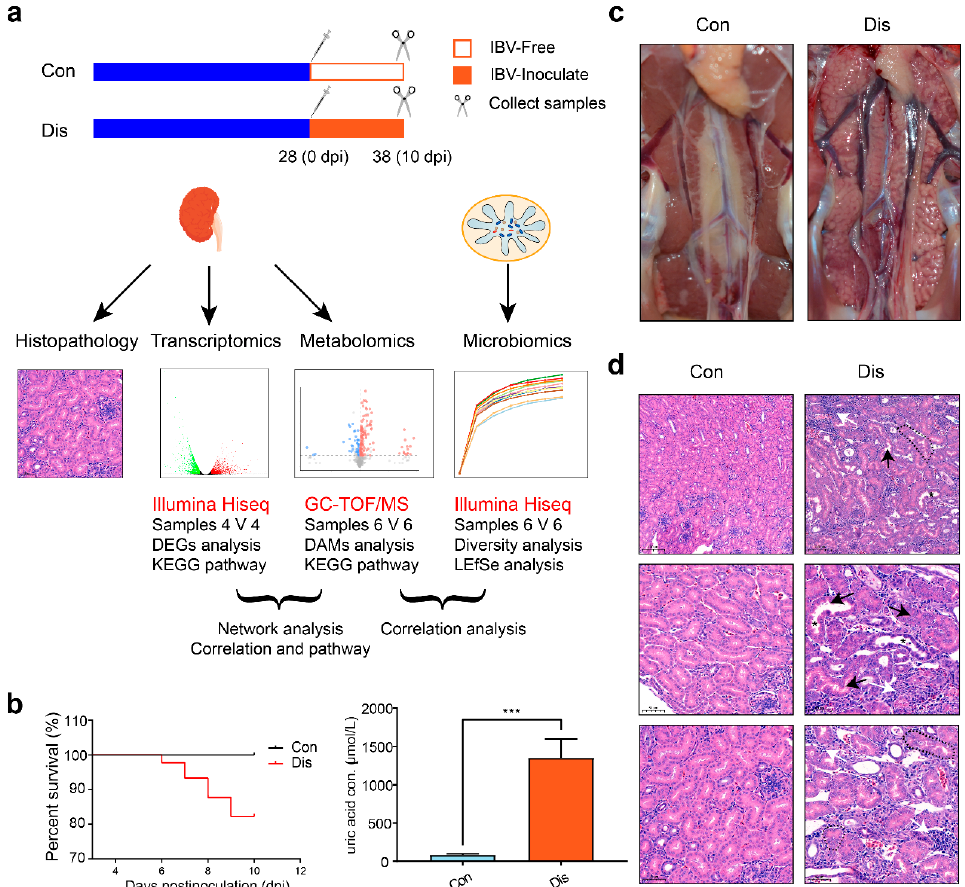
Figure 1. Changes in the kidney of chickens infected with nephropathogenic infectious bronchitis virus (NIBV). ( a ) Experimental design, including the analysis of transcriptomics, metabolomics, and microbiomics. ( b ) Analysis by Kaplan–Meier curve of 10 dpi survival rate in NIBV-infected chickens and uric acid concentrations in the serum. ( c ) Gross lesions in the kidneys. Kidney tissue of an uninfected control chicken (left). Obvious enlargement and urate deposition in the kidney of a chick infected with NIBV at 10 dpi (right). ( d ) Histopathological changes in the kidney of chickens infected with NIBV (H&E staining). The black arrow shows the shedding of kidney tubular epithelial cells and the white arrow shows the interstitial expansion and prominent inflammatory cell infiltration. The black asterisk shows the brush border that was lost in some segments of proximal tubules. The black delimited area shows the loss of the kidney tubular structure.